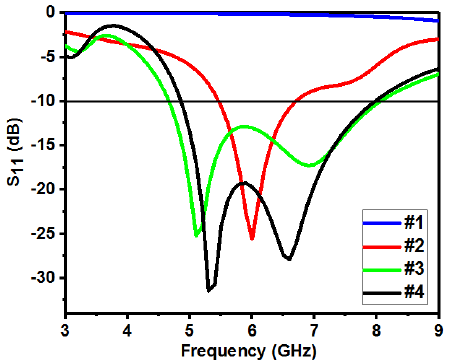
Figure 2. Design evolution reflection coefficient (S 11 ) The detailed layout dimension of the proposed